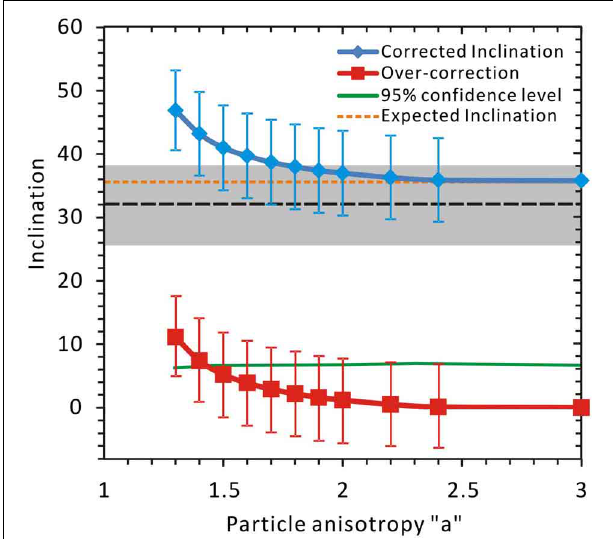
FIGURE 10 | Examination of over-correction of inclinations with varying individual particle anisotropy “ a ” from 1.3 to 3 for the 2–5m segment of the GHE27L. The black dashed line and the gray shaded area indicate the mean uncorrected inclination and associated 95% confidence interval for the 2–5m segment of Core GHE27L. Over-correction is defined as the difference between the corrected inclination (blue curve) and the expected inclination (orange dashed line) for a given “ a ” factor. The over-correction is indicated by the red curve. The green curve represents the 95% confidence limit of the corrected inclinations. If a mean over-correction exceeds the green curve for a given “a” factor, the over-correction is considered significant. The over-correction becomes significant for “ a ” < 1.4 at which the mean over-corrections exceed the 95% confidence